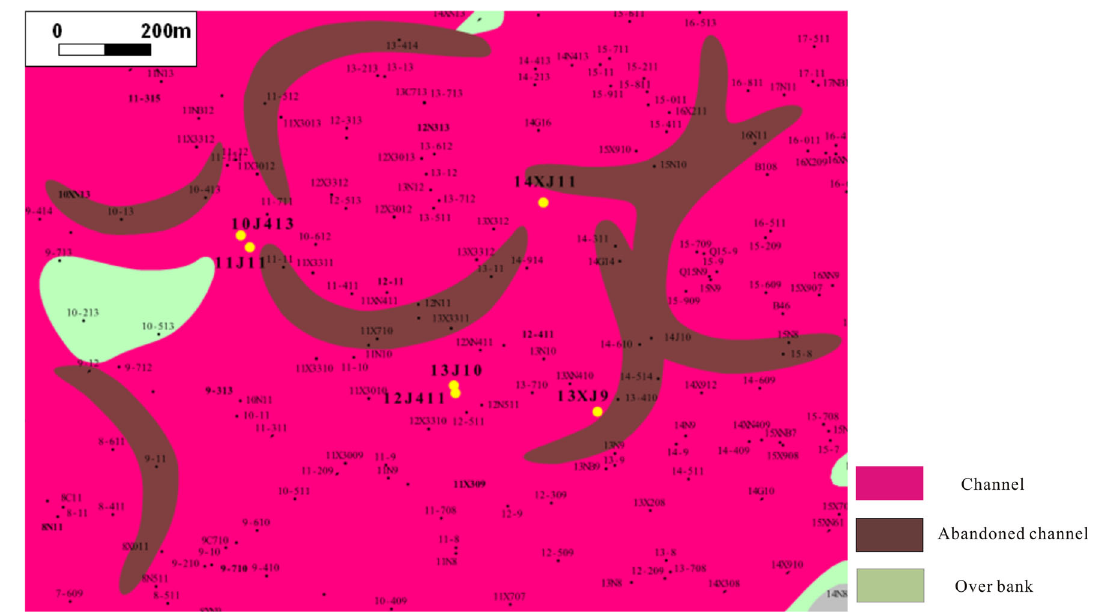
Fig. 6 Single point bar identification in channel belt: abandoned channel represents distribution of point